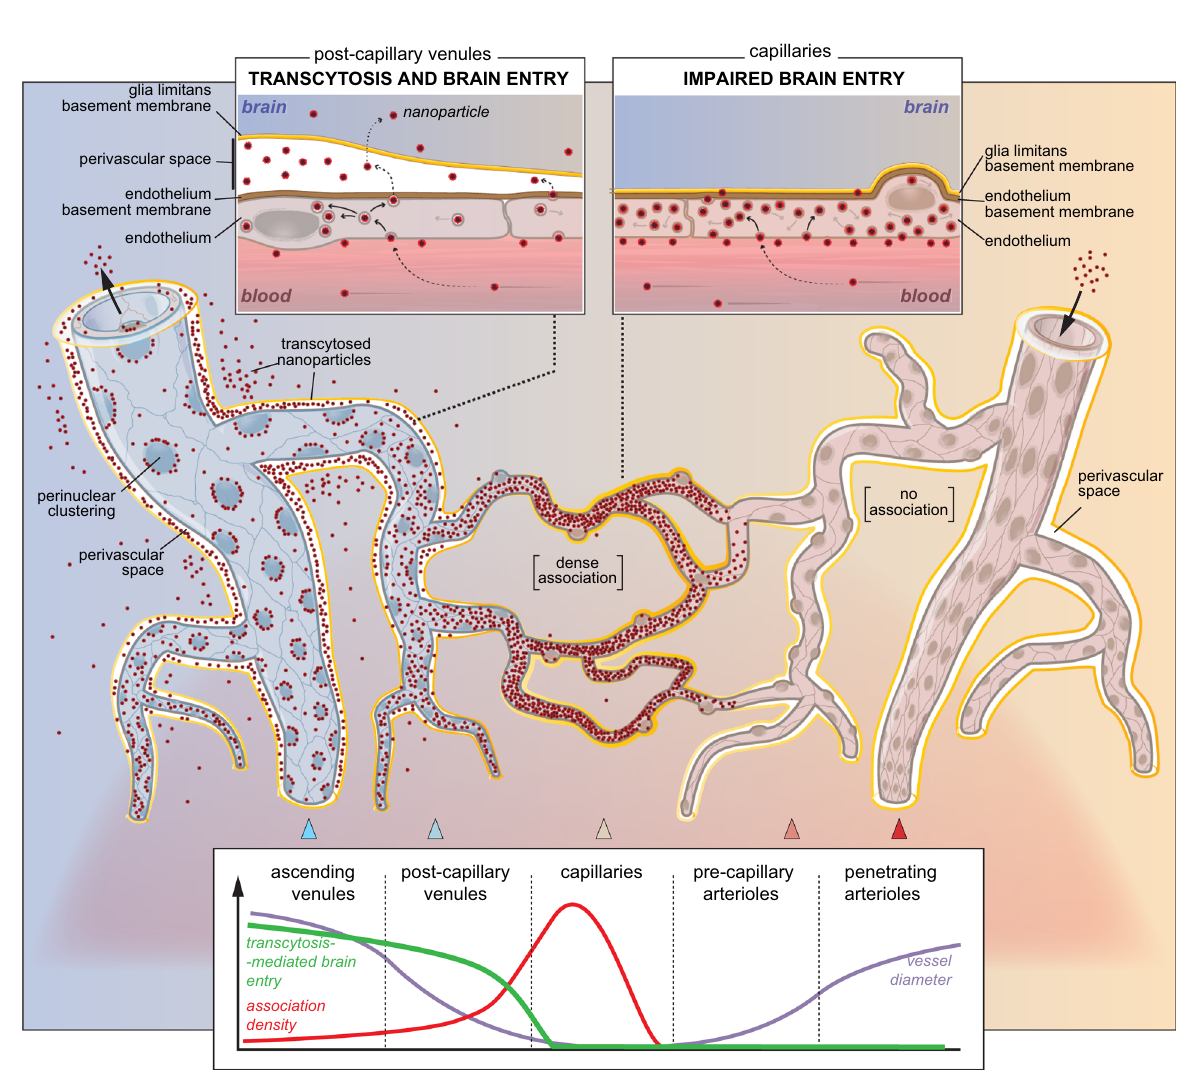
Fig. 7 Working model of transcytosis-mediated nanoparticle delivery to the brain. Despite the highest association to capillaries, the TfR-mediated delivery of liposome nanoparticles occurs almost exclusively in post-capillary venules, and is negligible in capillaries, where the lack of perivascular space impedes the progression of nanoliposomes into the brain